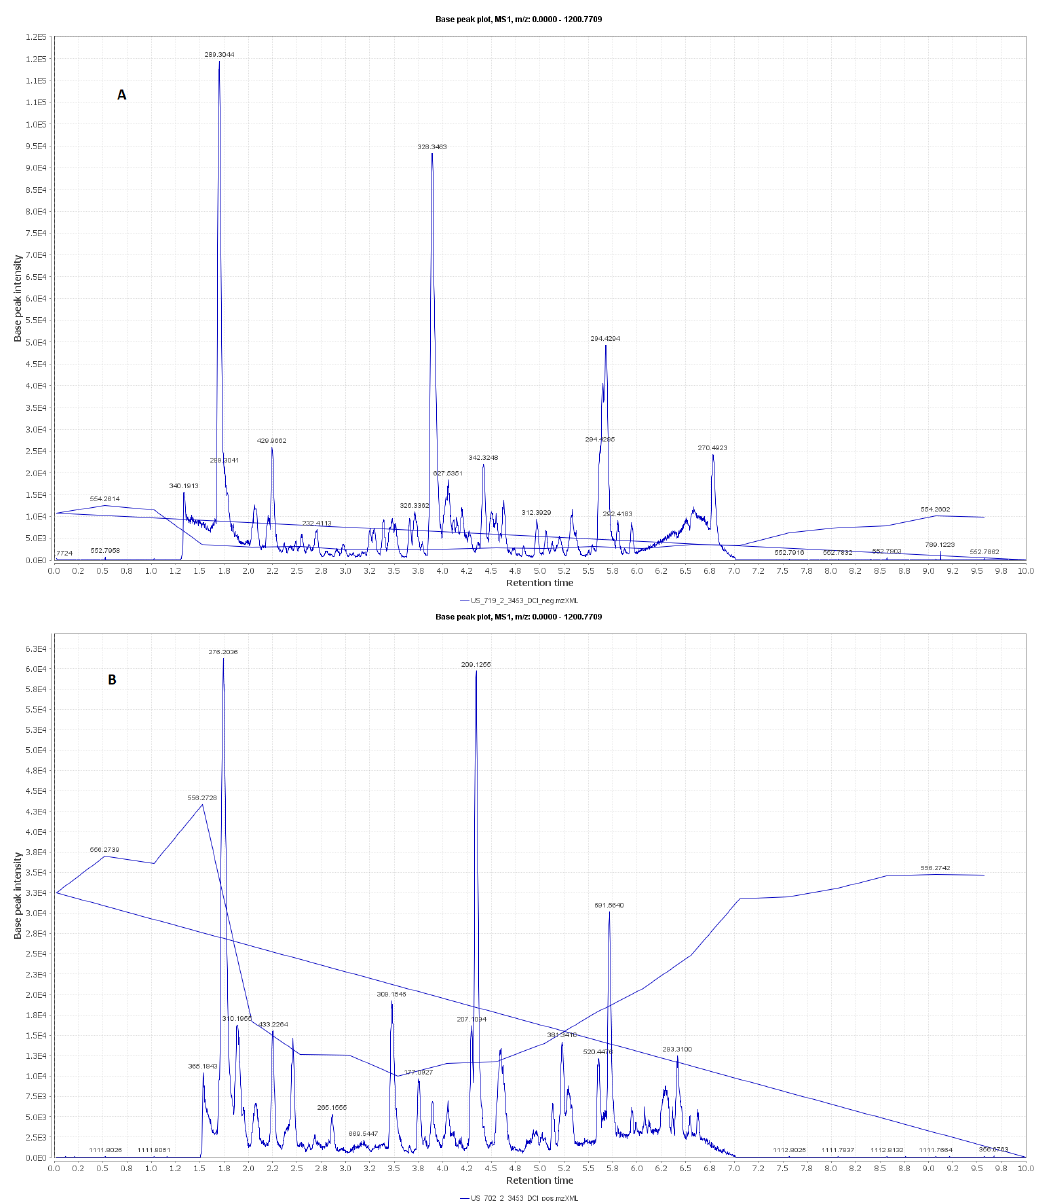
Figure 1. LC–MS total ion chromatogram ( A ) positive mode, ( B ) negative mode of the